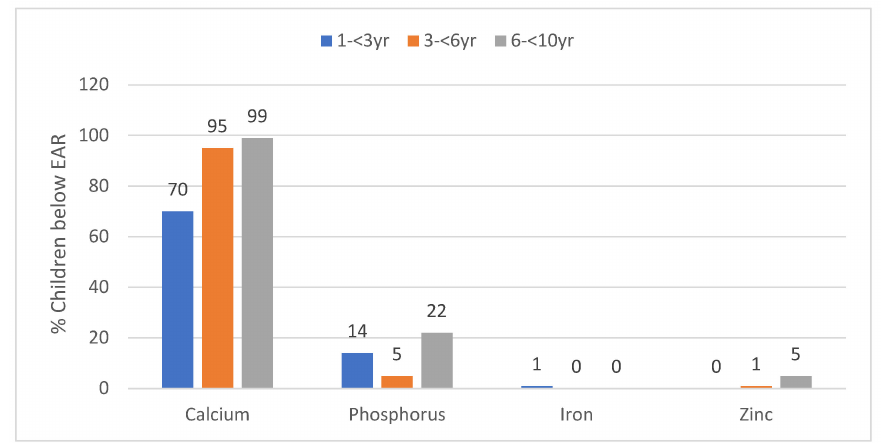
Figure 2. Percent children in the three age groups with values below the estimated average requirement (EAR) for minerals (taken to nearest decimal) .